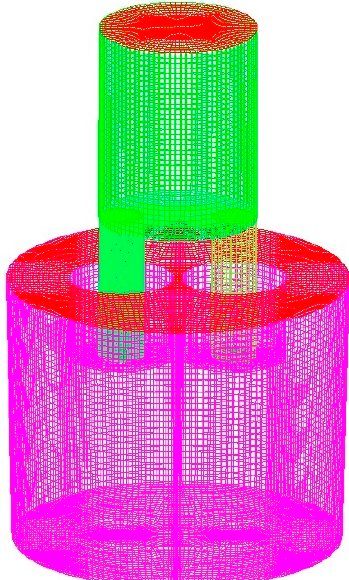
Figure 2. Different vacuum pressure drop modes.